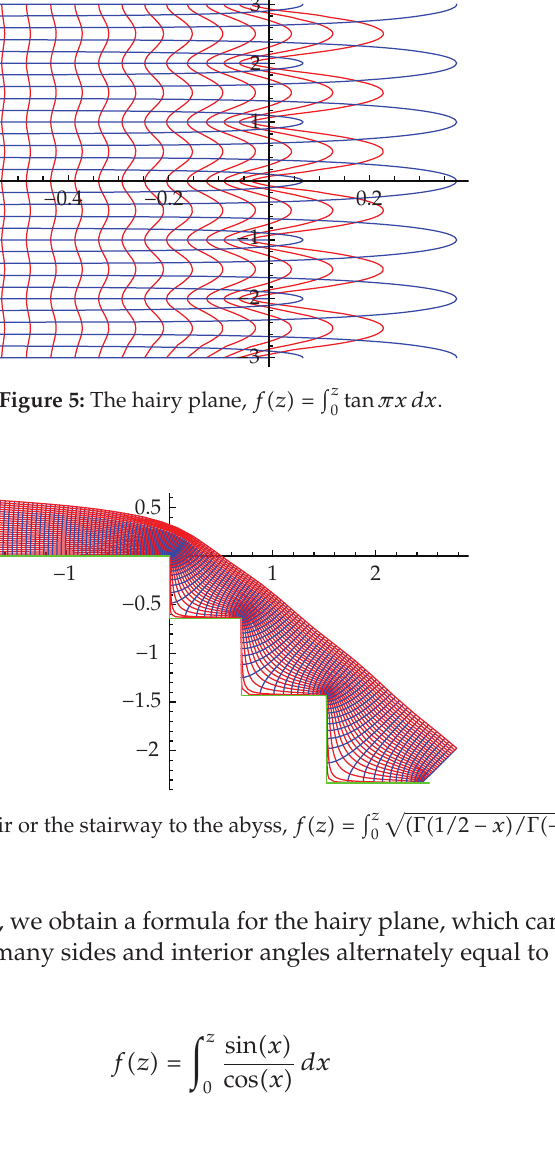
Figure 6: Half a stair or the stairway to the abyss, f (cid:5) z (cid:6) (cid:4)